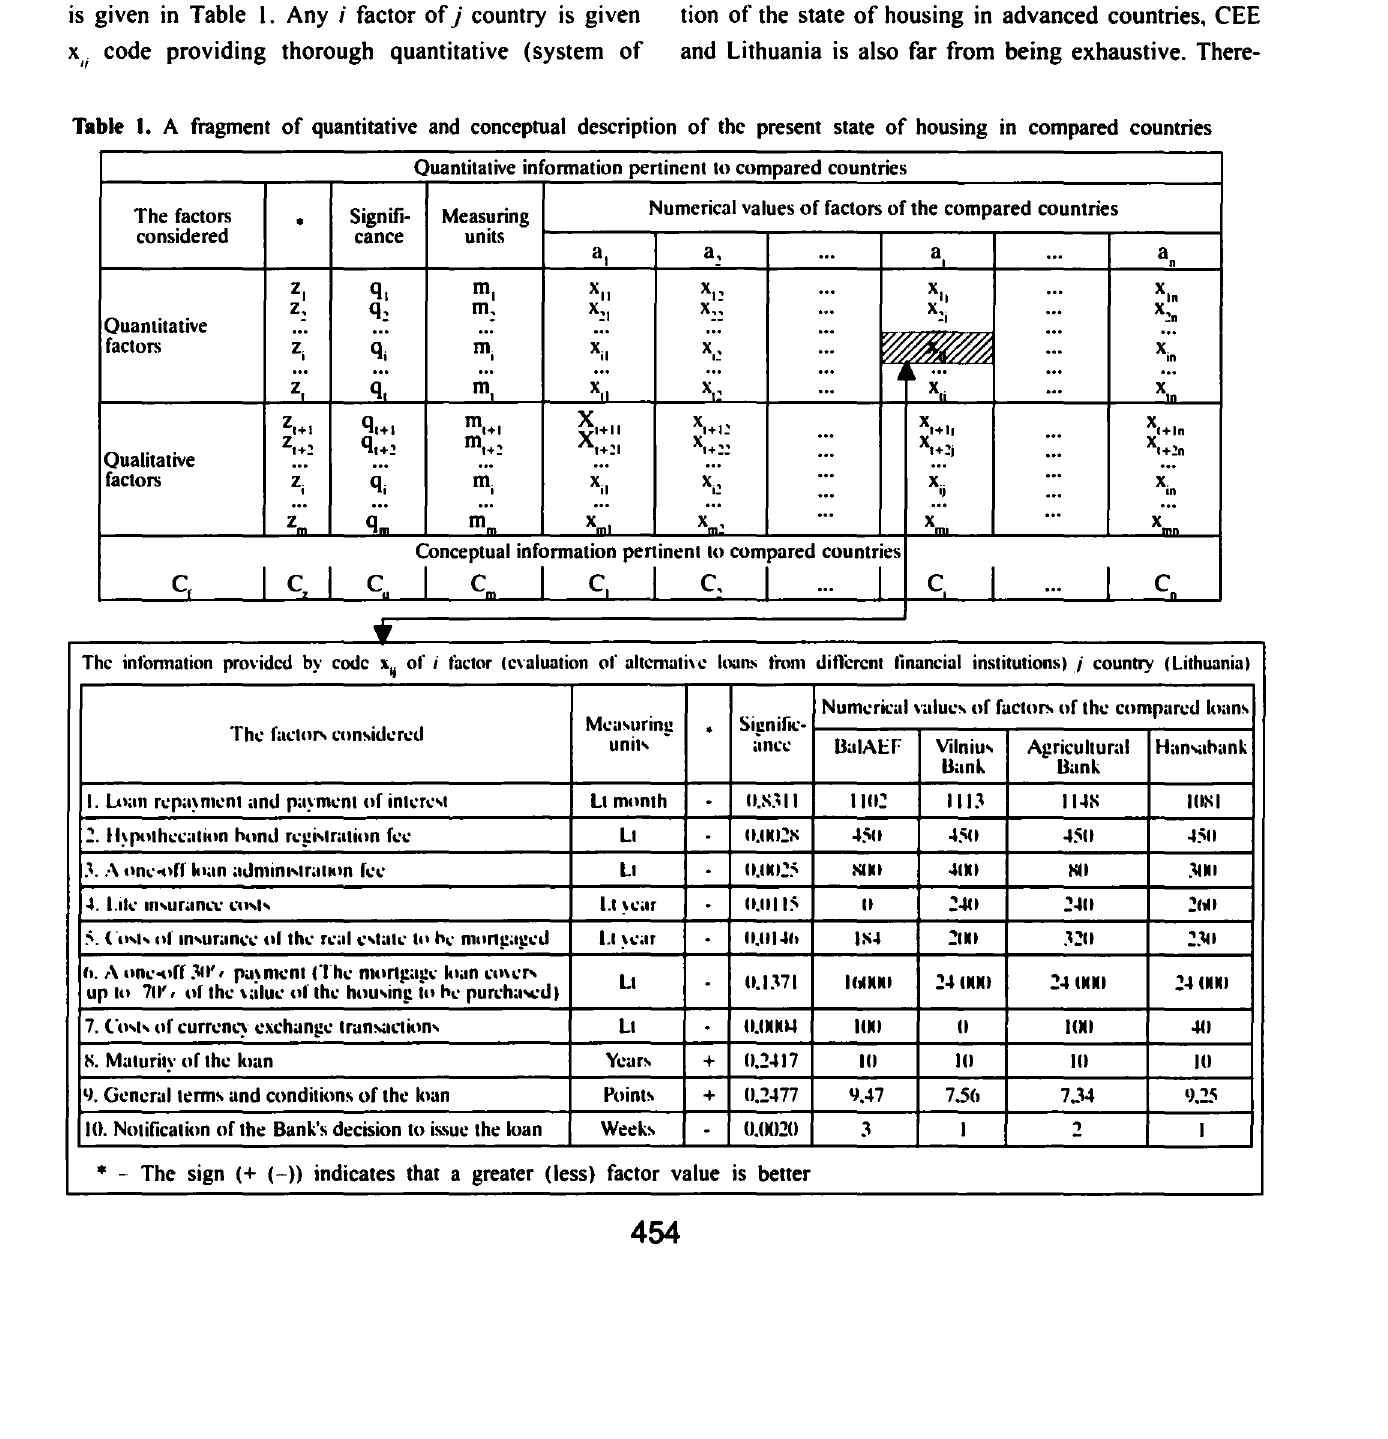
Table I. A fragment of quantitative and conceptual description of the present state of housing in compared countries ,... The factors • Signifi- Measuring Numerical values of factors of the compared countries cance units